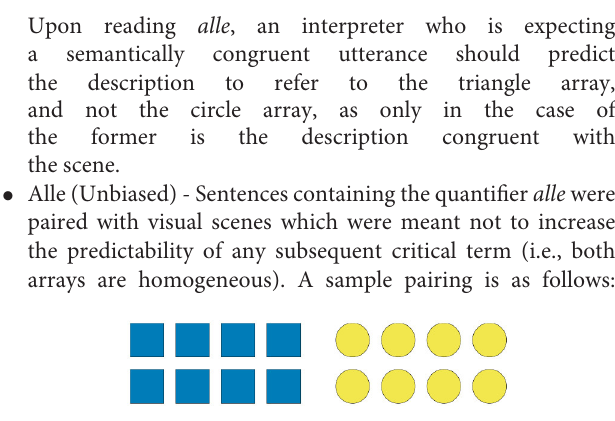
congruent utterance should predict description to the triangle array, the description congruent with